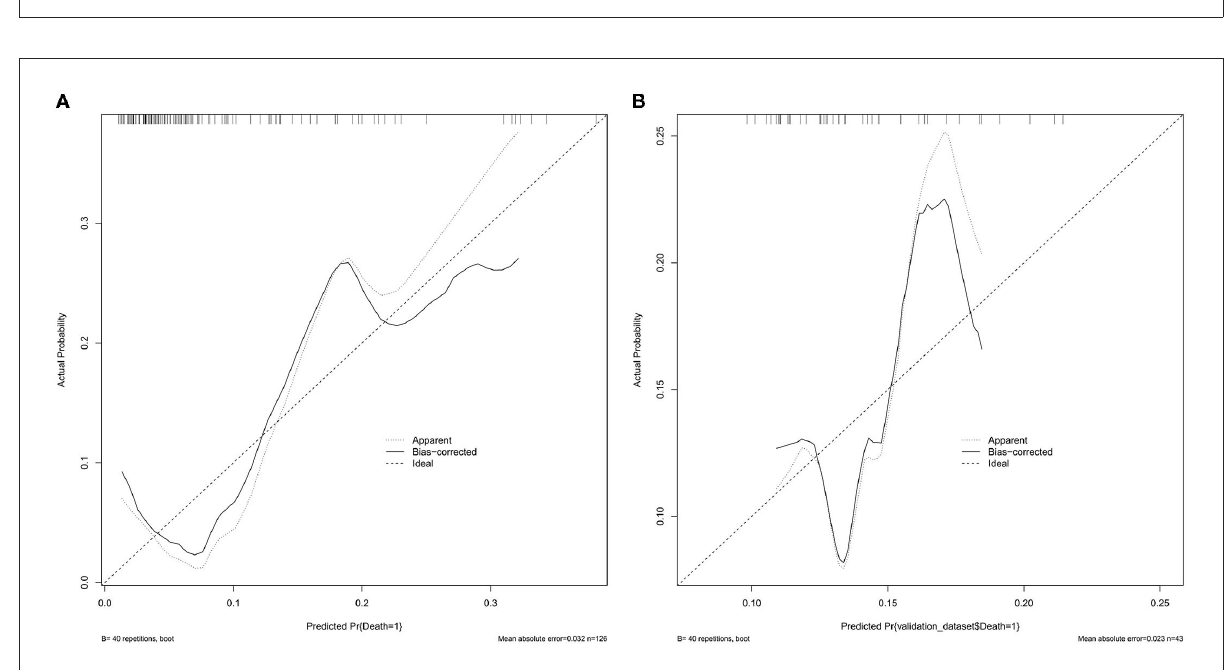
FIGURE6 (A) Calibration curve of training set data. (B) Calibration curve of testing set